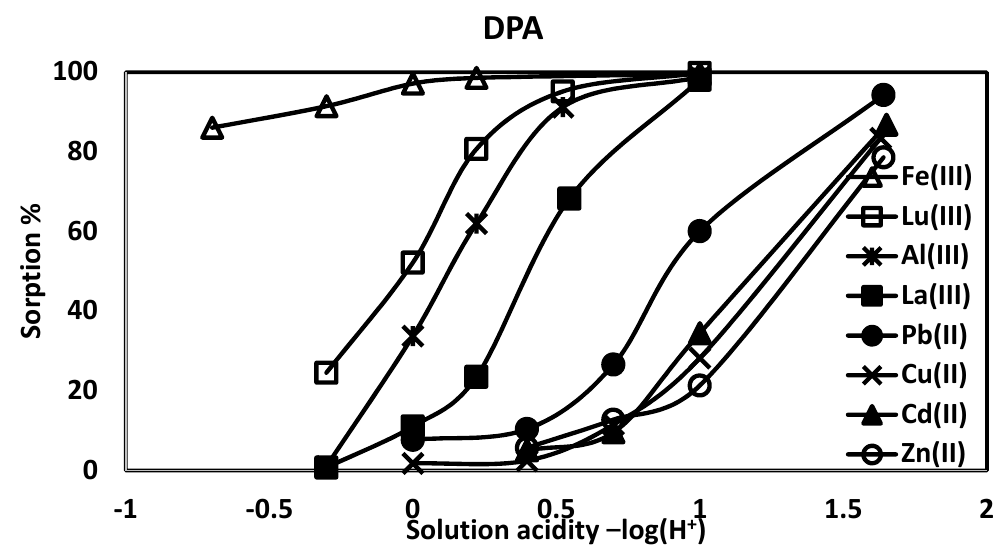
Figure 4. Divalent and trivalent metal ion affinities for the diprotic phosphonic acid, DPA.